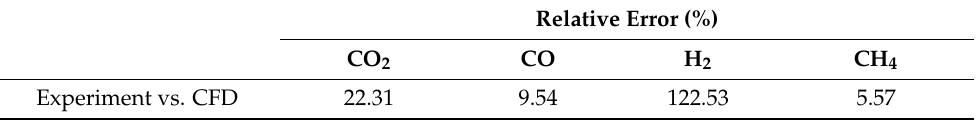
Table 10. Relative error analysis of CH 4 , CO 2 , CO and H 2 concentrations between average values obtained from the CFD model and laboratory tests for the coal sample from hard coal mine C.